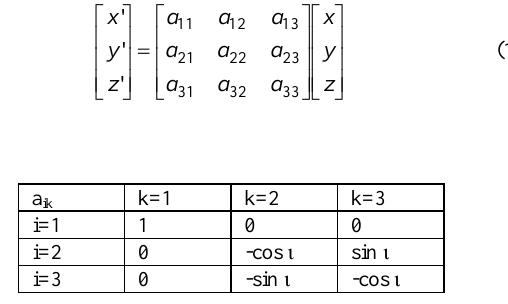
Table 2. Matrix elements of transformation equation of a Cartesian system Σ rotating with angle 180 o - ι around the x- axis into